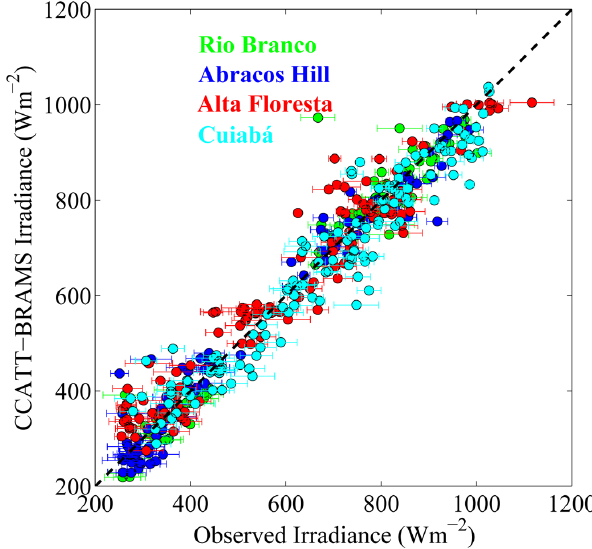
Fig. 7. Model-calculated (CCATT-BRAMS) versus observed down- welling solar radiation at the surface under cloud-free conditions at AERONET sites (Rio Branco, Abracos Hill, Alta Floresta and Cuiab´a).